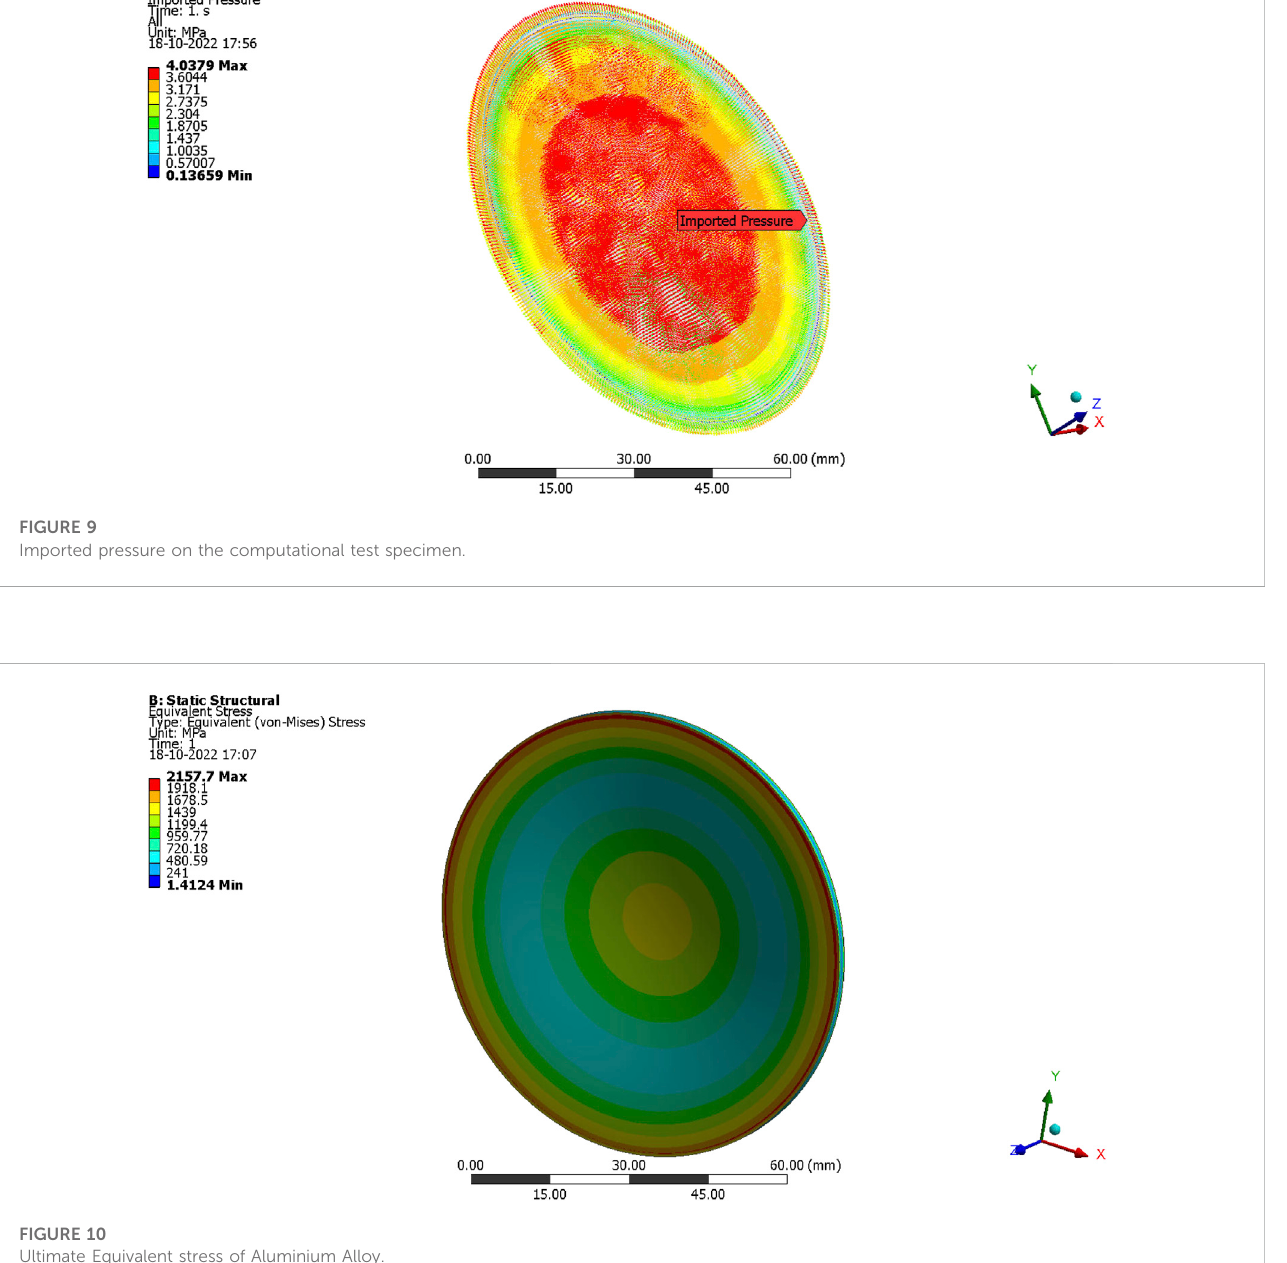
Ultimate Equivalent stress of Aluminium